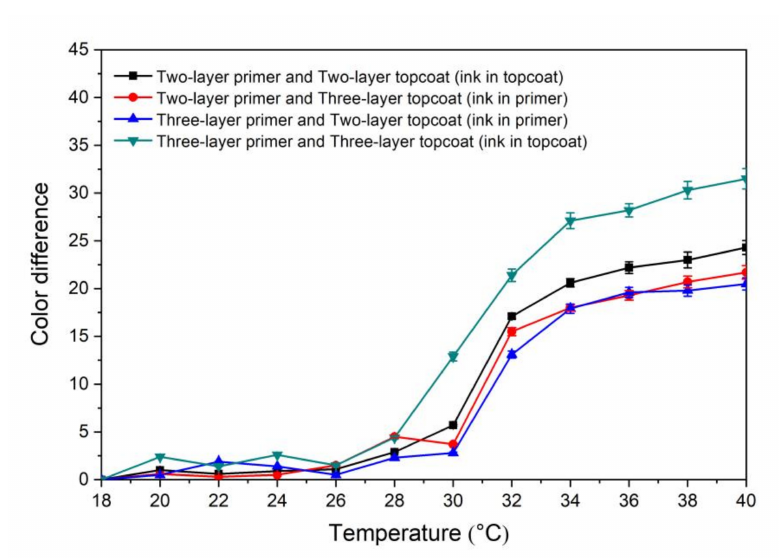
Figure 3. Particle size distribution of microcapsules.